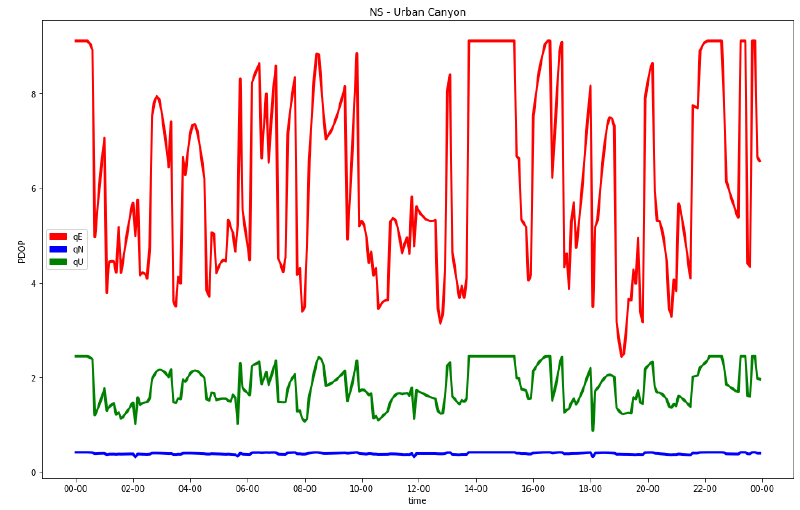
Figure 10. Diagonal coefficients in N (blue), E (red) and U (green) coordinates of final co-factor matrix in NS street (C5N5-CG-TDoA) for urban canyon.